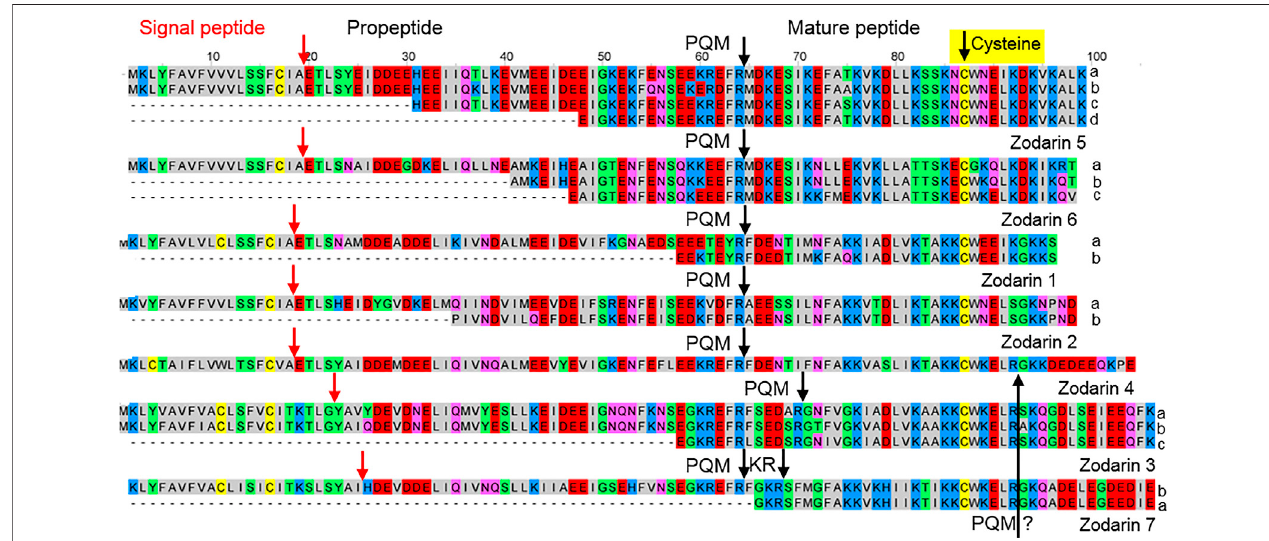
FIGURE6 | Overview ofcysteinecontainingLPs identi fi ed in the venom gland transcriptomeof Zodarion cyrenaicum (Zodarin 4) and Zodarion styliferum (Zodarins 1, 2, 3, 5, 6, 7). The cutting site (arrow) of the signal peptidase is colored in red and processing sites between propeptides and mature peptides are colored in black. Cationicaminoacidsarecoloredinblue,anionicaminoacidsinred,thecorrespondingC-terminalamidvariantsinpink,hydrophobicaminoacidsinblack,Cysinyellow, and polar amino acids in green. A further possible PQM processing site was identi fi ed C-terminally in zodarins 3, 4, and 7 and is colored in